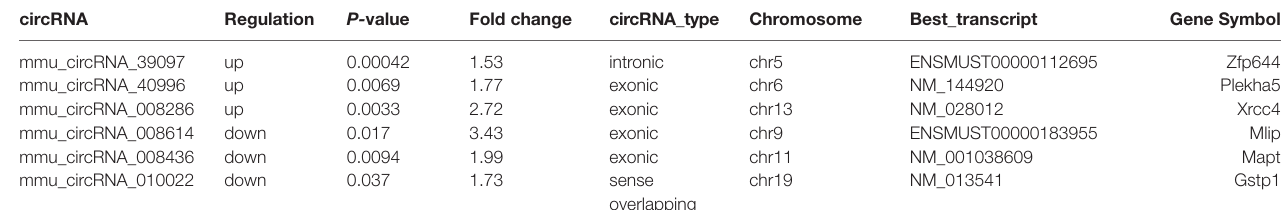
TABLE 1 | Three significantly up/downregulated